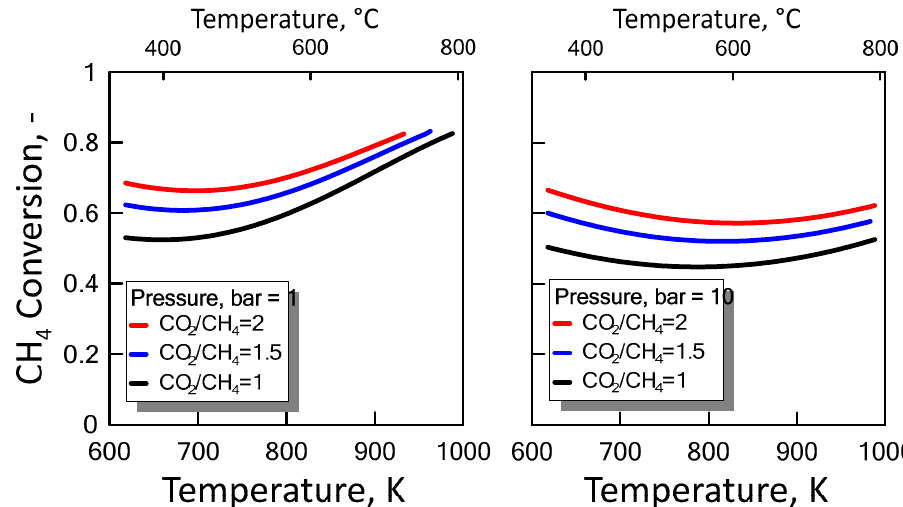
Figure 7. CH 4 equilibrium conversion at 1 bar ( left side) and 10 bar ( right side) as a function of temperature at different CO 2 /CH 4 feed molar ratio taking into account carbon formation.